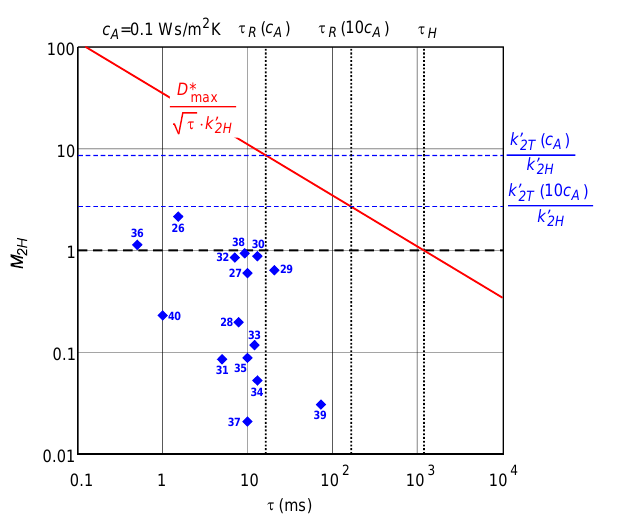
Table 4. Dimensionless figure of merit M 2H and references of the tag numbers of the bolometric radiation sensors, cf. Figs. 3 and 5.